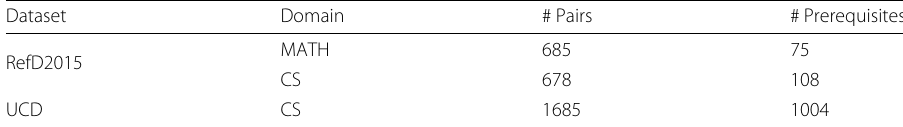
Table 1 Supervised Model Training and Evaluation Datasets